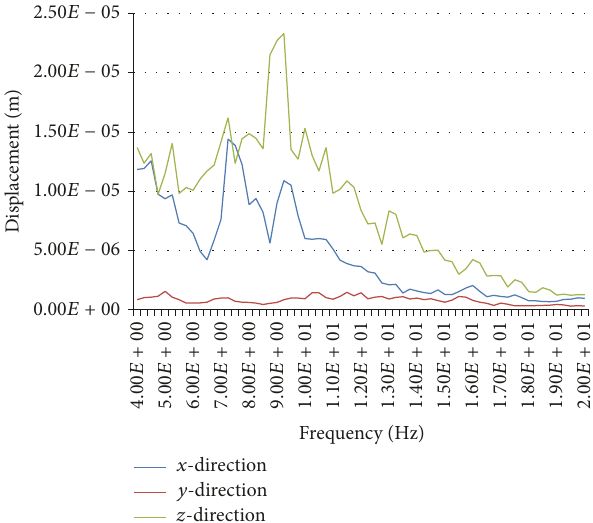
Figure 14: The FFT spectrums of Location 3.